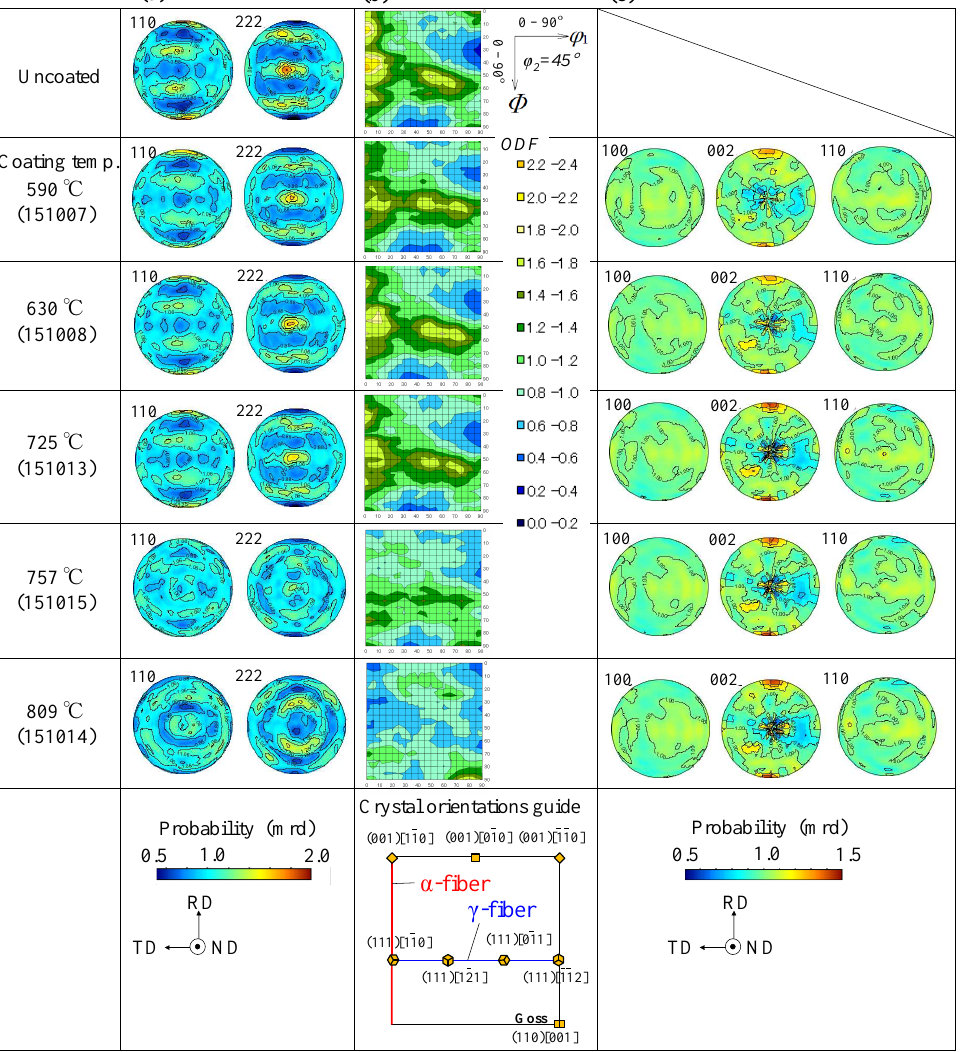
Figure 2. Texture of uncoated and coated samples. ( a ) Pole figures for γ -U, ( b ) ϕ 2 = 45 ◦ orientation distribution function (ODF) section showing γ -U texture, and ( c ) pole figures for α -Zr. ND: sample normal; RD: rolling direction; TD: transverse direction.